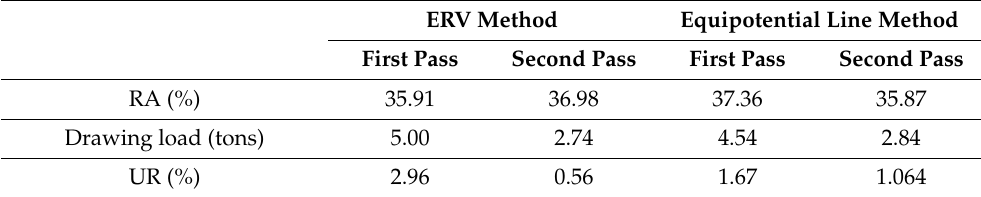
Table 2. Results of the FE analysis for the cross-roller guide.